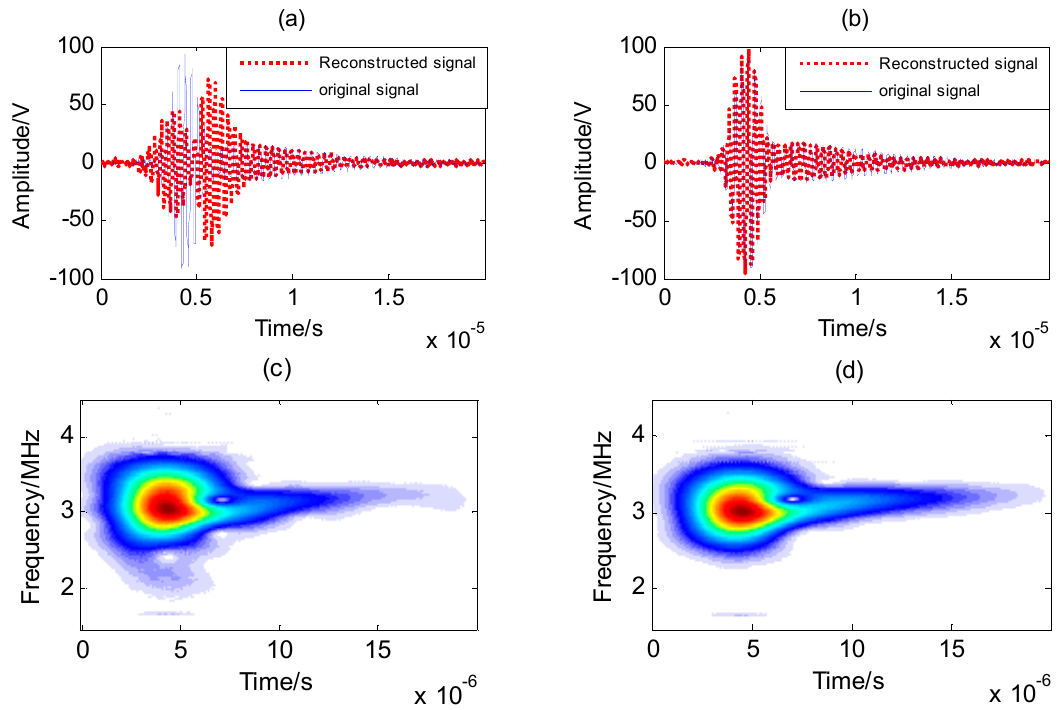
Figure 6. ( a ) The reconstructed multimodal signal using the time-frequency blind signal separation method and the original signal at the distance of 1.6 cm; ( b ) the reconstructed multimodal signal using the proposed method and the original signal at the distance of 1.6 cm; ( c ) the time-frequency distribution of the original signal at the distance of 1.6 cm; ( d ) the time-frequency distribution of the reconstructed signal at the distance of 1.6 cm.